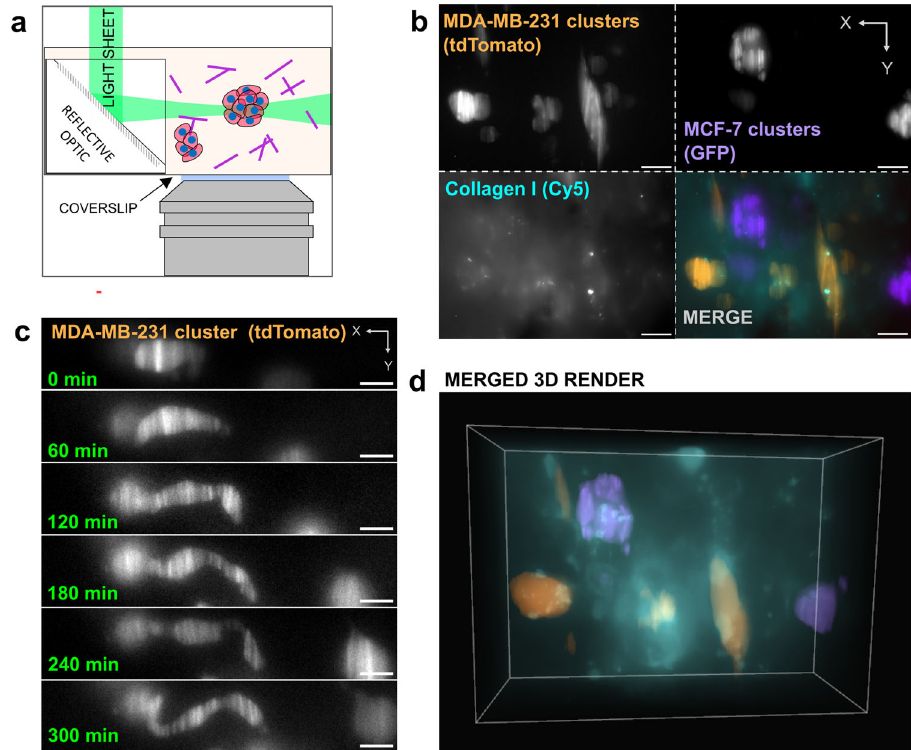
Fig. 2 Light-sheet fl uorescence microscopy (LSFM) with OptoRheo. a Schematic of light-sheet microscopy on the OptoRheo. Sample consists of cell clusters (represented by red circles with blue centres) and collagen (purple lines). b Multicolour imaging of a co-culture of MDA-MB-231 (top left corner of montage) and MCF-7 (top right corner) in hydrogel supplemented with Cy-5 labelled collagen I (bottom left corner) on the OptoRheo with three colour channels. Images in montage are maximum intensity projections. Scale bar = 20 µ m. c Single planes from time lapse movie (Supplementary Video SV1) taken on the OptoRheo of a MDA-MB-231 cell cluster changing morphology. Scale bar = 10 µ m. d 3D rendering of b .